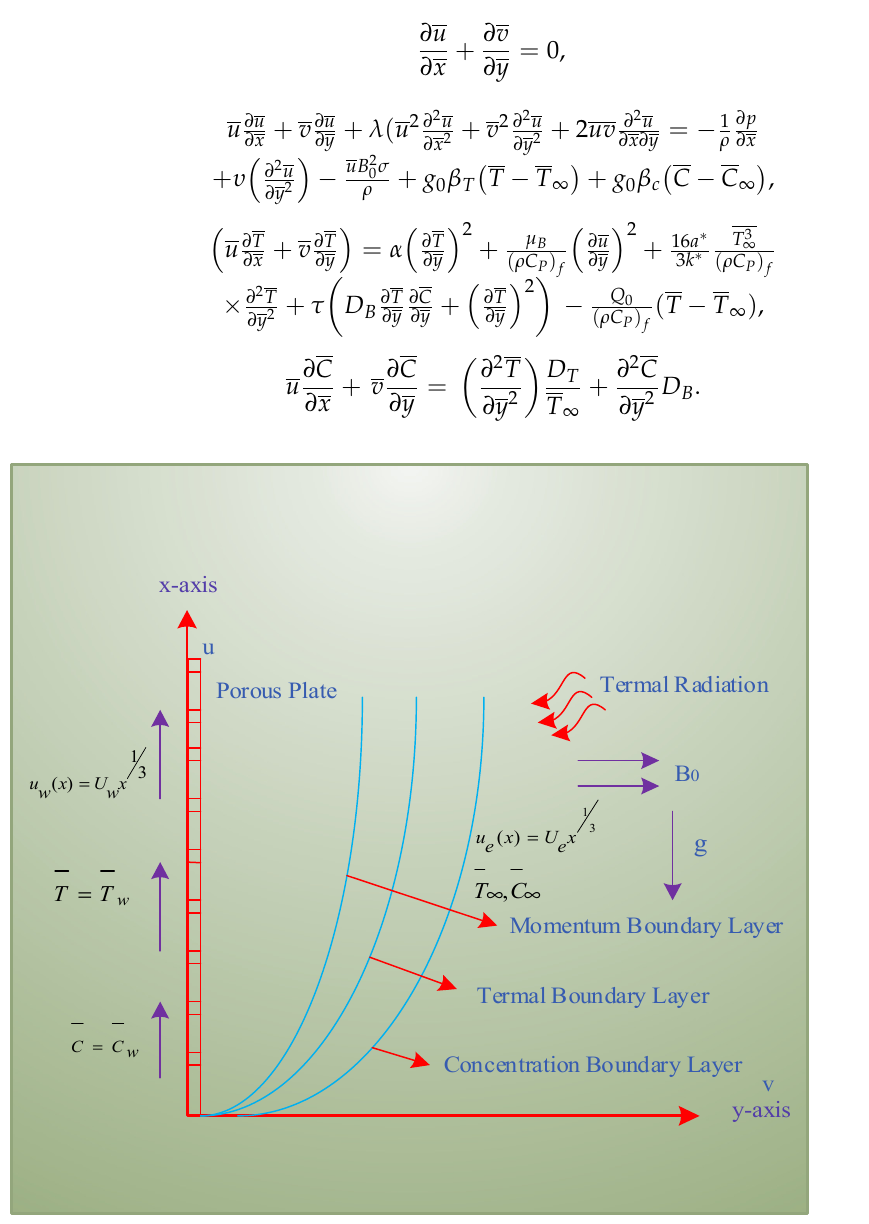
Figure 1. Flow geometry for HTM-BFN model with MHD. In terms of boundary conditions,